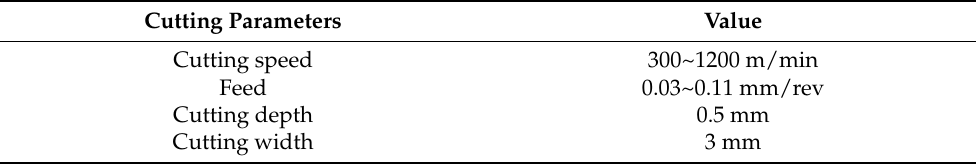
Table 3. The cutting parameters setup of high-speed milling